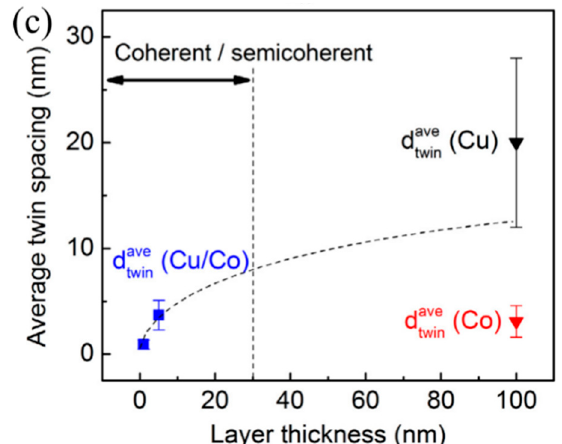
Figure 6. ( a ) XRD profiles of Ag/Al multilayer films with varying h , showing epitaxial character for all multilayer films. Only a single peak was present when h reduced to 25 nm. As h decreased to 10 nm, satellite peaks of multiple orders began to appear; ( b ) XRD results of Mg/Ti NMMFs with h ranges from 2.5 nm to 200 nm. The primary diffraction peaks correspond to Mg (0002) and Ti (0002) (the basal planes). For large individual layer thickness, Ti (10-10) reflections also become visible. It is observed that the peak breadth becomes larger with decreasing h . Satellite peaks start to emerge around the primary peaks at small h . ( c ) The interface structure evolution with layer thickness h in (111) Cu/Co multilayers. Note that the interface is coherent at h < 25 nm, while the interface is semicoherent at h > 25 nm [4,20,32].